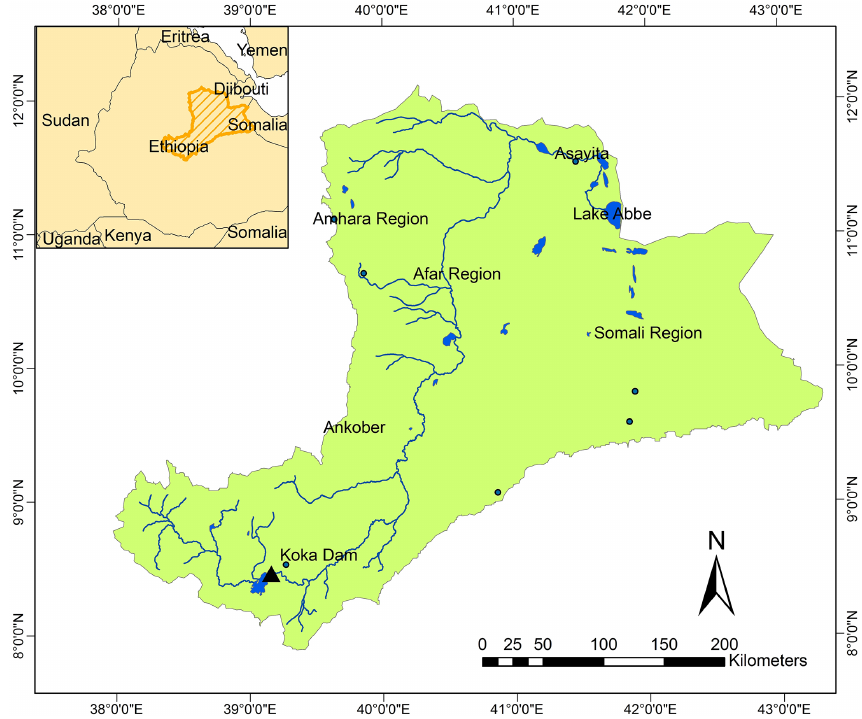
Figure 1. Location of the Awash River basin in the central Rift Valley of